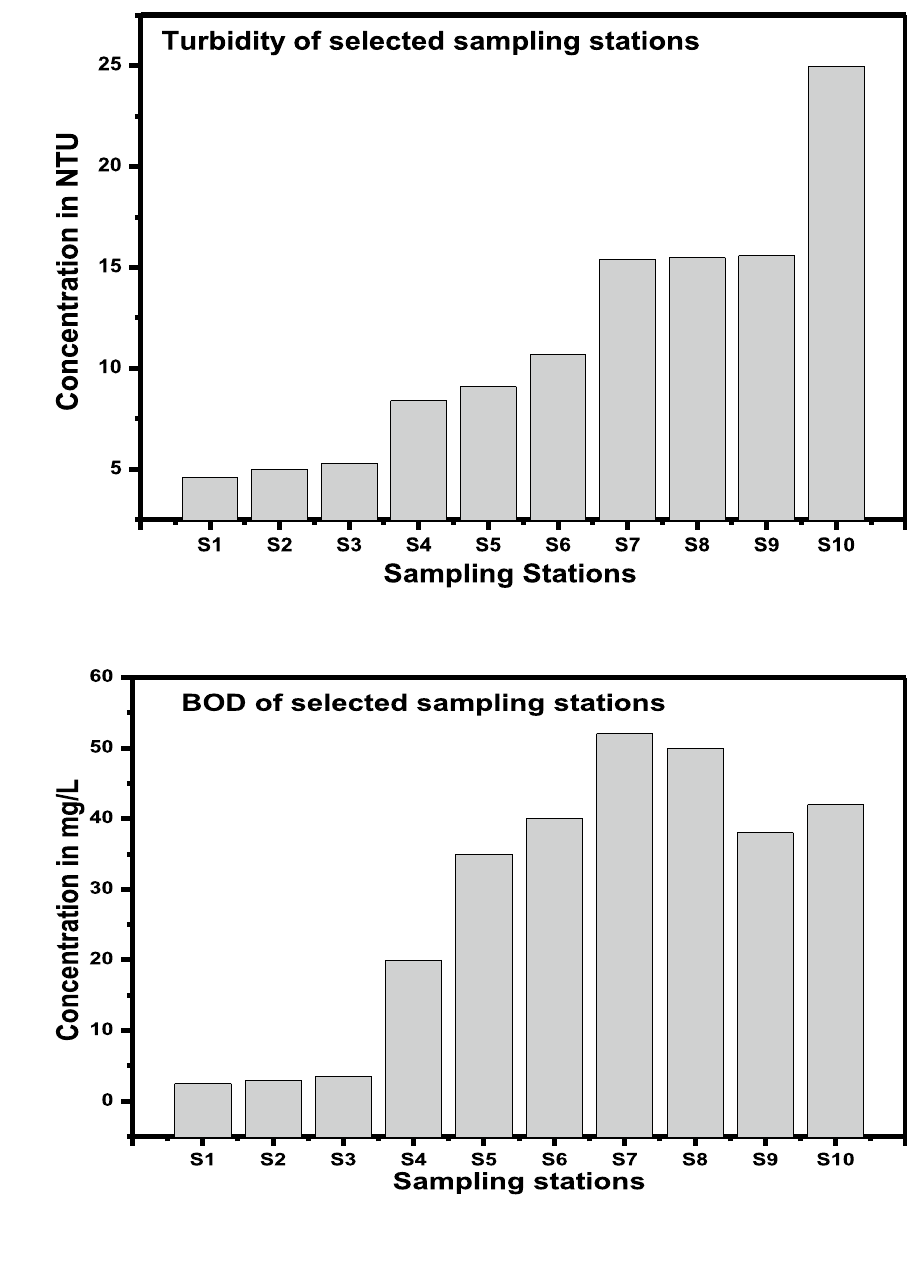
Fig. 6 Turbidity of selected sampling stations